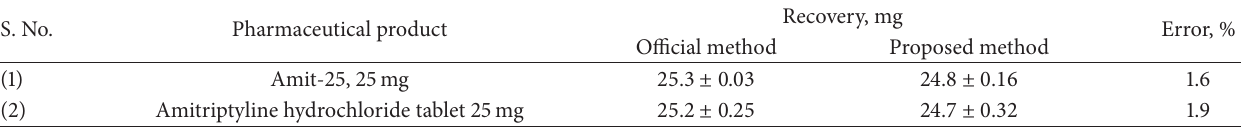
Table 2: Performance data for spectrophotometric determination of amitriptyline. S.